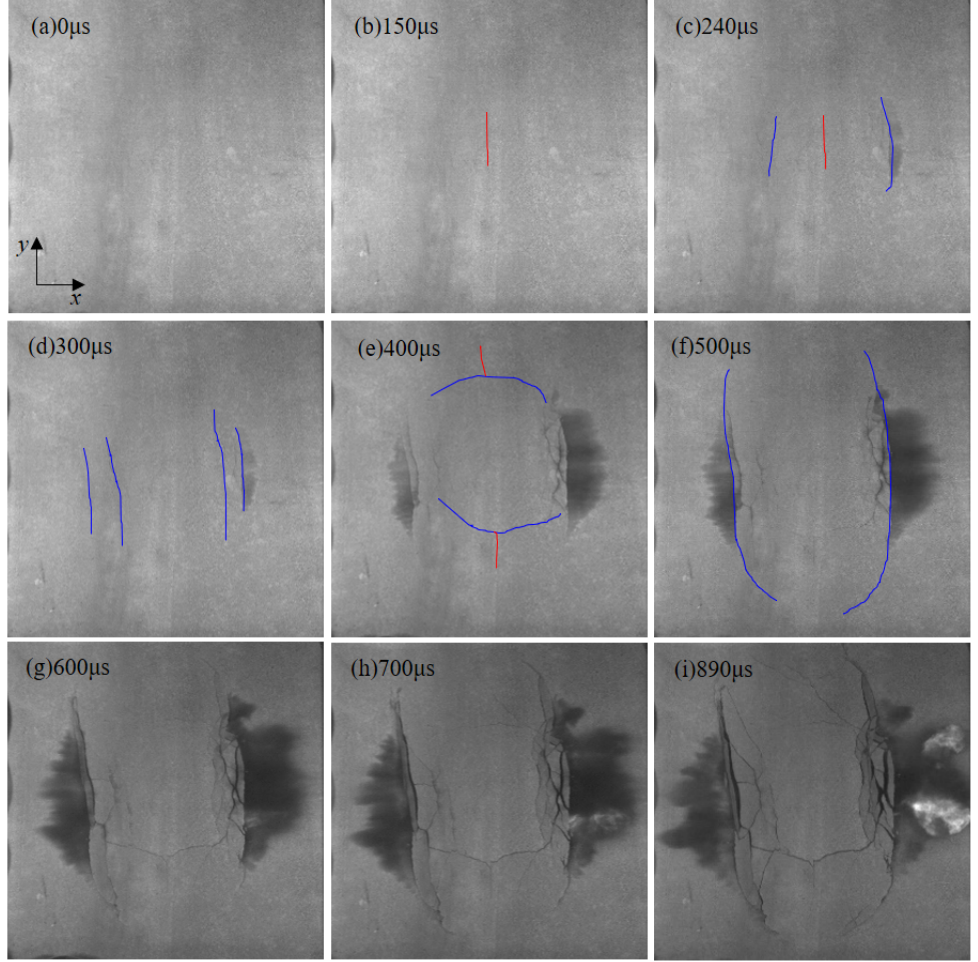
Figure 8. The crack network at different times during crater blasting under an SSR of 0.4. ( a – i ) The crack network after 0, 150, 240, 300, 400, 500, 600, 700, and 890 μs of explosion, respectively. crack network after 0, 150, 240, 300, 400, 500, 600, 700, and 890 µ s of explosion,